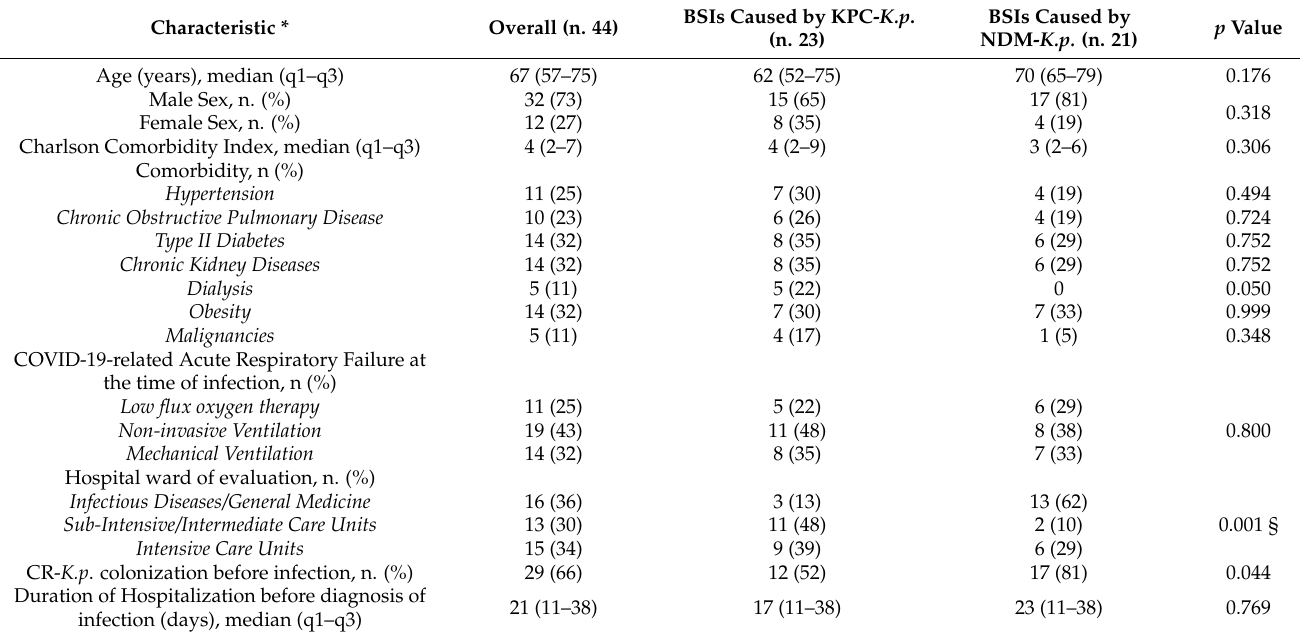
Table 1. General characteristics of the study